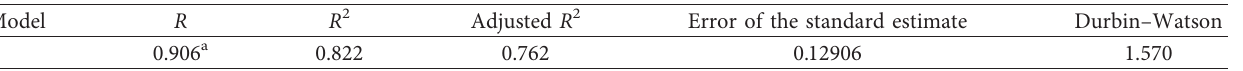
Table 8: Model summary b